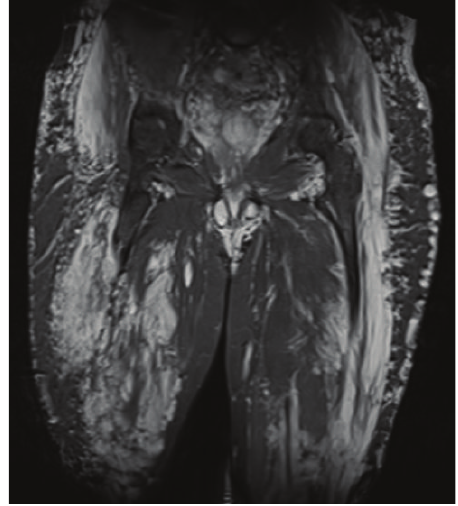
Figure 3: Coronal MRI STIR sequence of the anterior thigh.